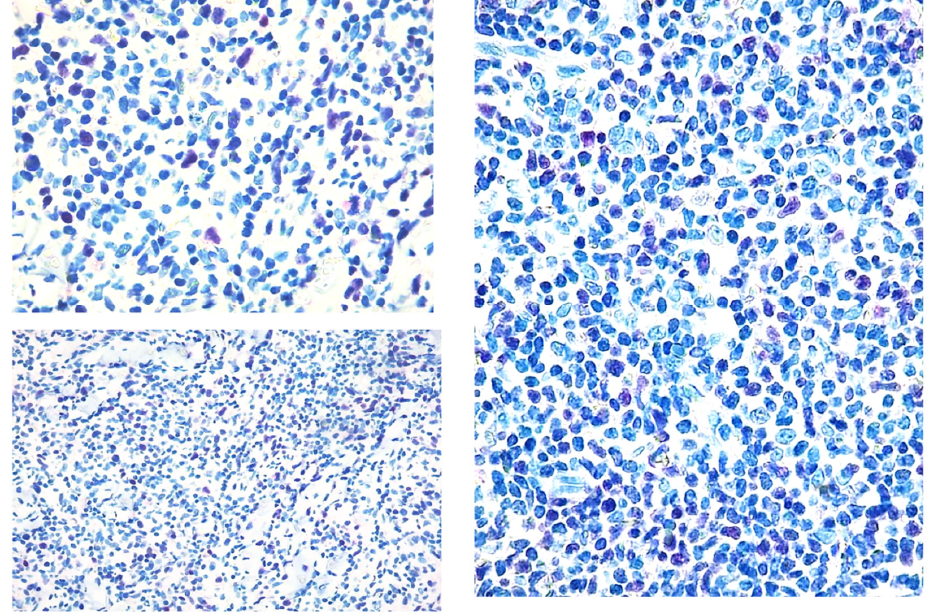
Figure 2. Paradigmatic example of score 2 of Tox expression in different cases.